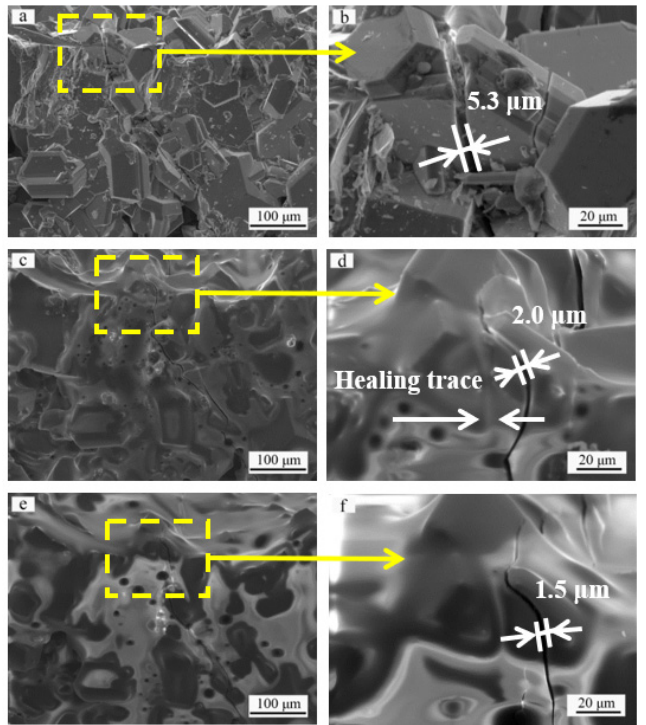
Figure 4. Surface morphologies of the SiC coating: ( a ) original surface before oxidation, ( b ) magnified image of the selected area in ( a ) showing a typical crack with 5.3 μ m in width, ( c ) top view of the same area in ( a ) after oxidation for 20 min, ( d ) magnified image of the selected area in ( c ) showing the healing of the crack, ( e ) top view of the same area in ( a ) after oxidation for 40 min, ( f ) magnified image of the selected area in ( e ) showing the healing of the crack.